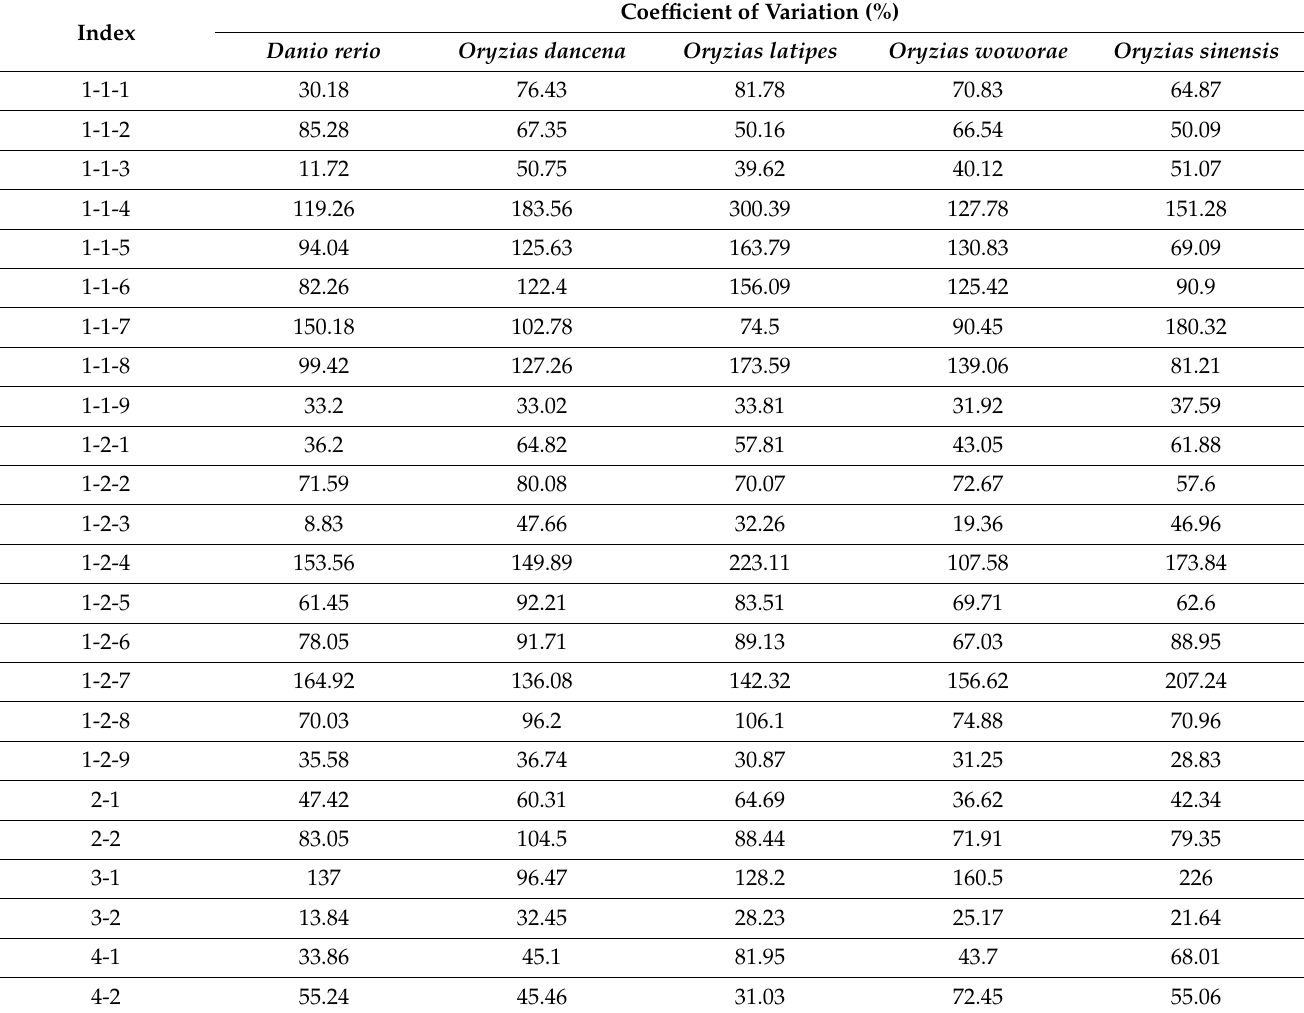
Table A5. Summary table of each strain coefficient of variation in each behavior